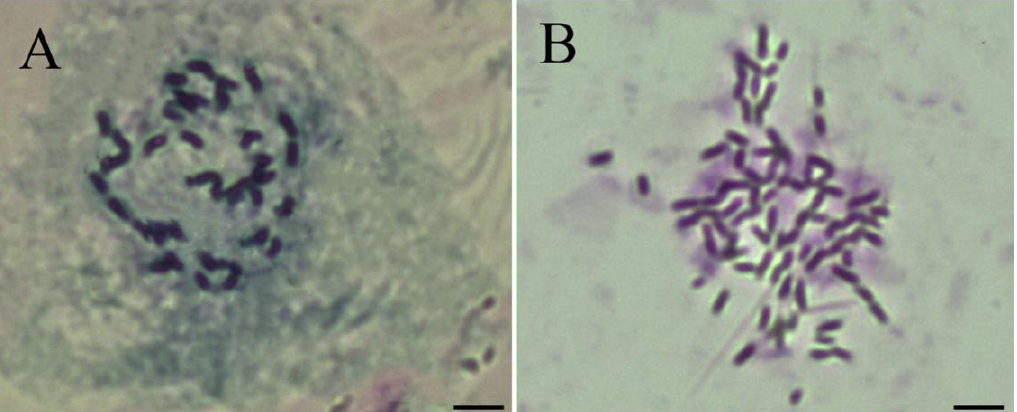
Figure 1. Karyotype analysis of chromosomes of deploid ‘Xingtao 0604′ (( A ), 2n = 2 x = 24) and autotetraploid ‘Zhuguang’ (( B ), 2n = 4 x = 48), Bars = 5μm.